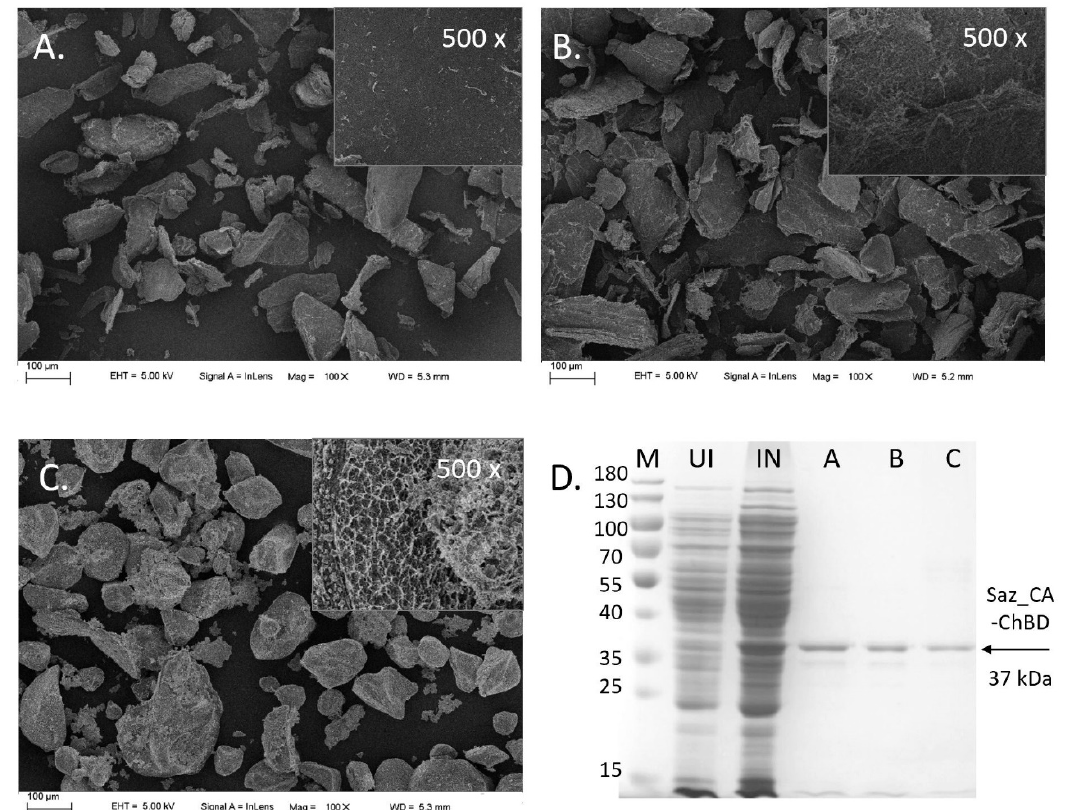
Figure 3. Saz_CA-ChBD immobilised on different chitin supports. ( A – C ) Scanning electron microscope